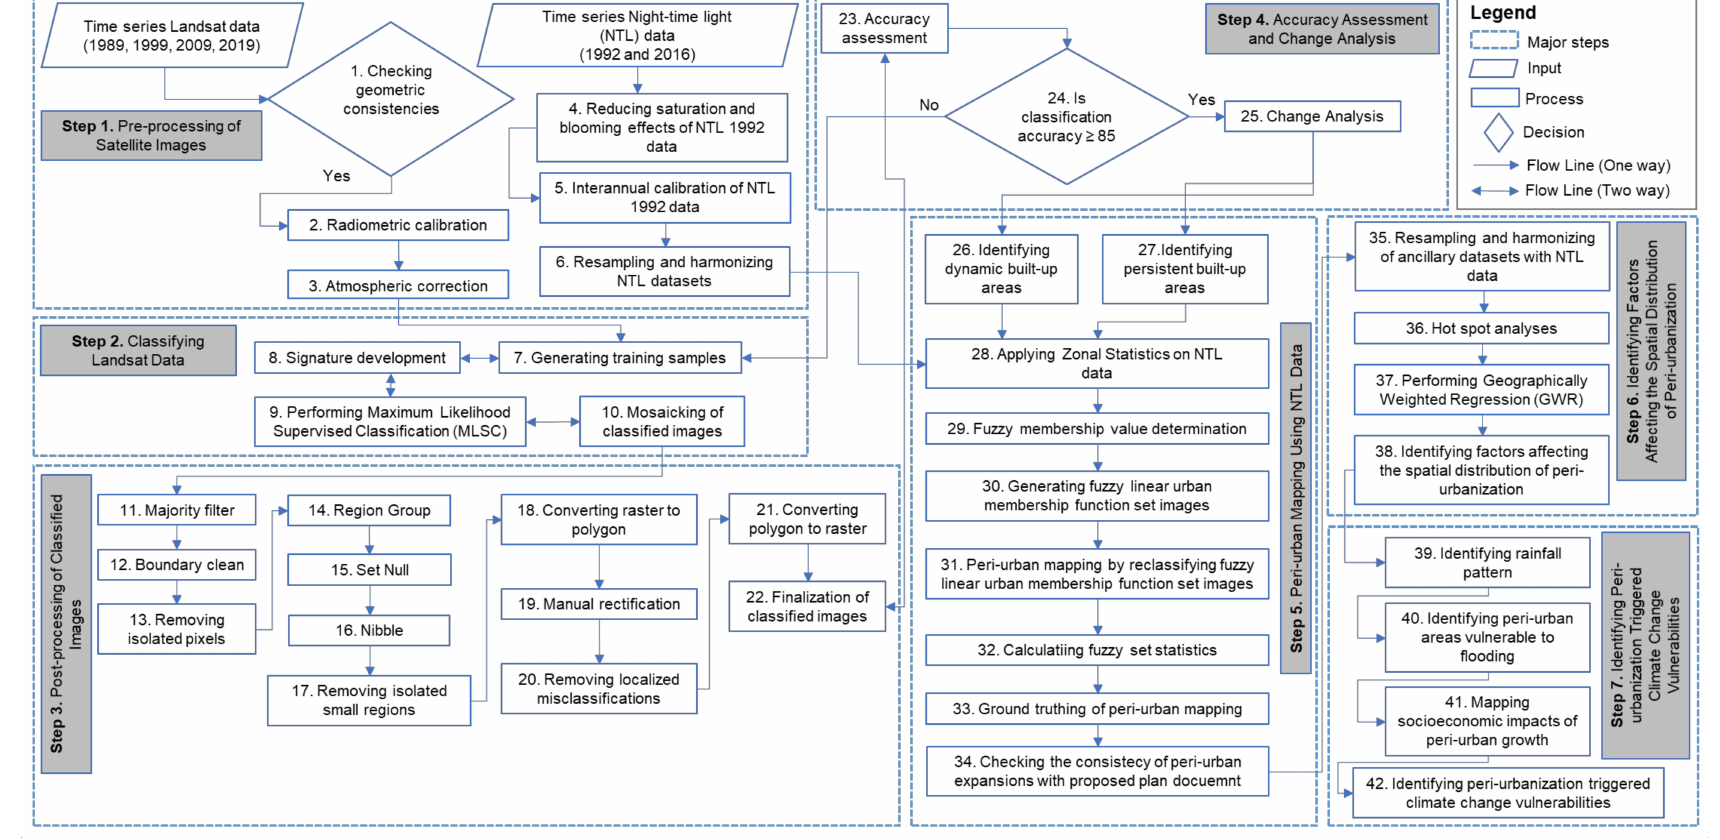
Figure 2. Methodological steps of this